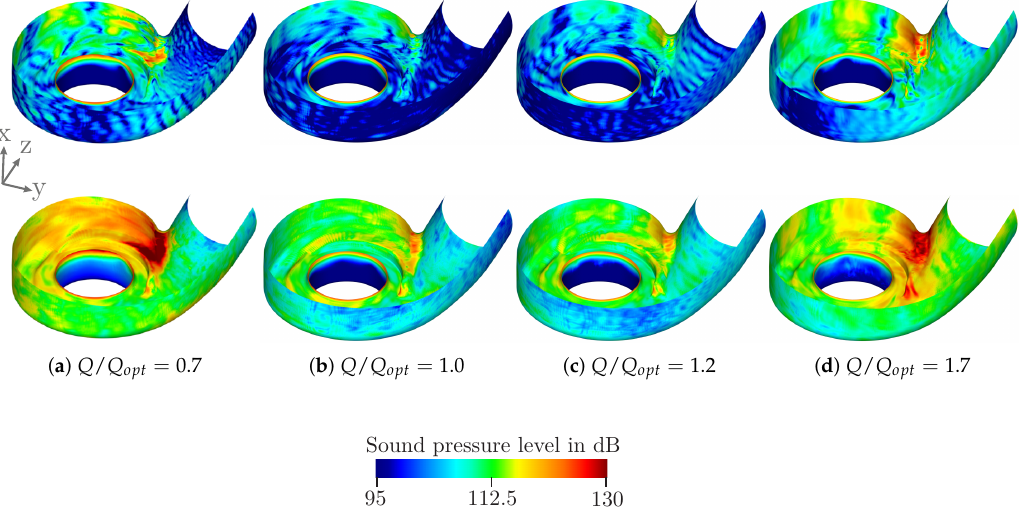
Figure 16. Wall sound pressure level of housing filtered around BPF ( top ) and in a broadband range of 100–2500 Hz ( bottom